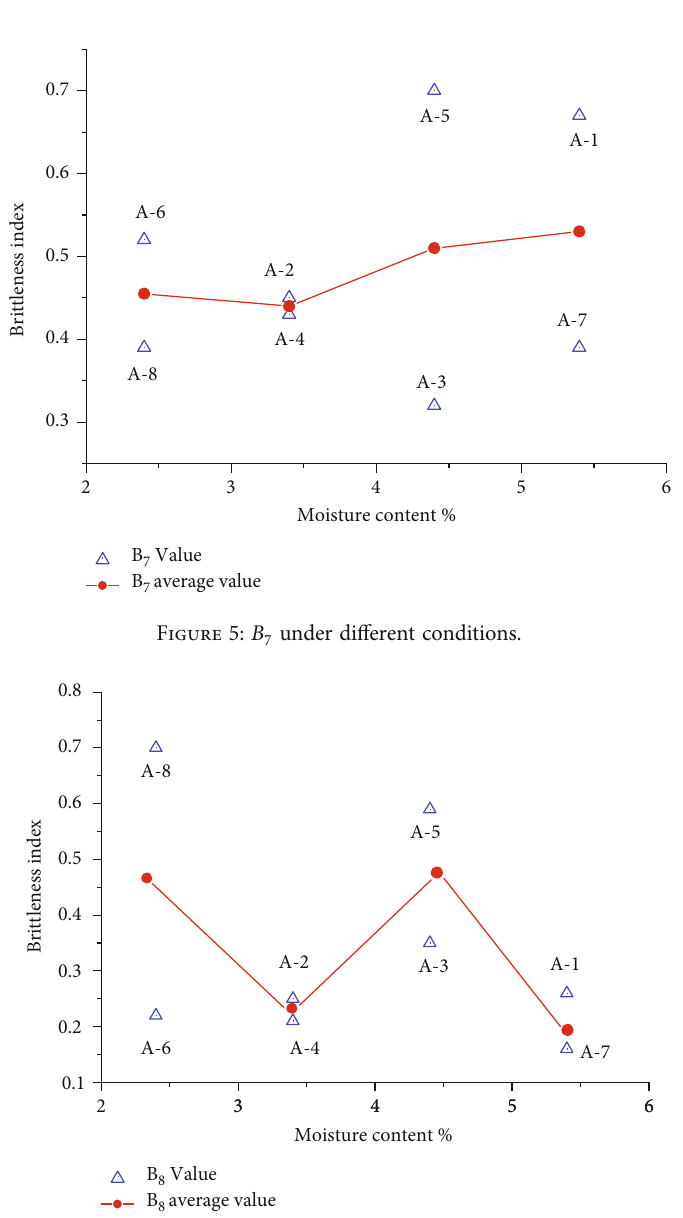
Figure 6: B at di ff erent water 8